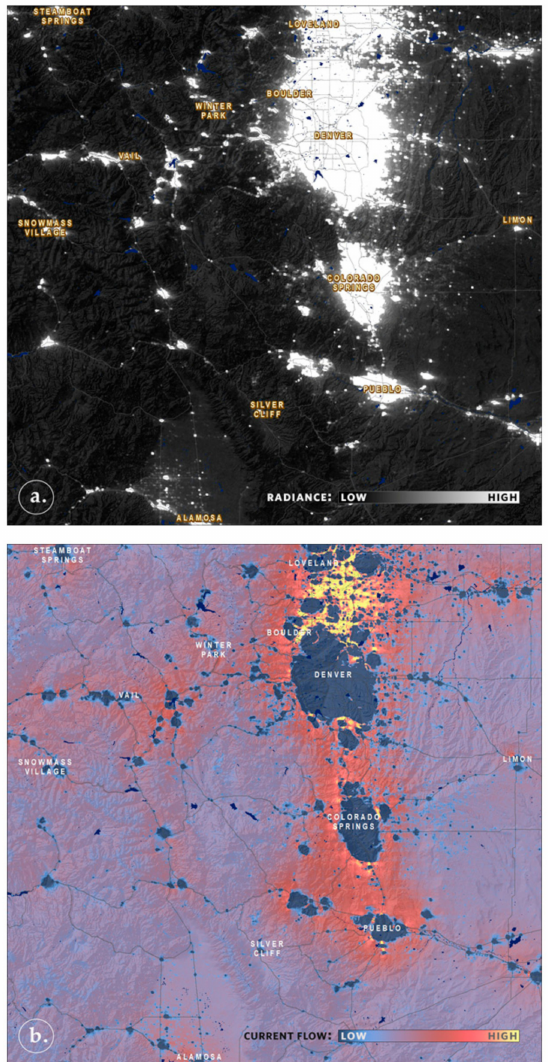
Figure 5. VIIRS Nighttime Lights radiance values ( a ) were used as the resistance and source strength grids for Omniscape.jl [51] to explore the influence of anthropogenic activities on structural con- nectivity in the wildland-urban interface in Colorado, USA. Areas with high radiance values had high resistance, and low source strengths (i.e., source strength grid was the inverse of the resistance grid). Major roads (dark blue) and topography (hillshade) have been included on the map to aid in interpretation. Normalized current flow ( b ) is very low (dark blue) in cities due to high resistance and low source strength, as determined by the high nighttime light radiance values. Current flow that is displaced from areas with many nighttime lights is most concentrated (highest current flow values, in yellow) in small pockets of areas with few lights between the major city of Denver and neighboring Loveland (to the north), which limits how far this displaced current can spread. In other places on the landscape where displaced current encounters lower resistance and thus more options, the landscape appears orange; pixels grade into reds and pinks in low resistance areas near scattered high resistance areas (e.g., in the upper left section of the map, around Vail and Winterpark). Areas with generally low resistance (few nighttime lights) are in purples—these can be interpreted as a “baseline”or “natural” current flow, with light blue zones indicating lower flow due to higher resistance, and many nearby options for where that displaced current could go. Both the broad flow patterns of moderate current, and the high flow concentration areas are important, but suggest different conservation